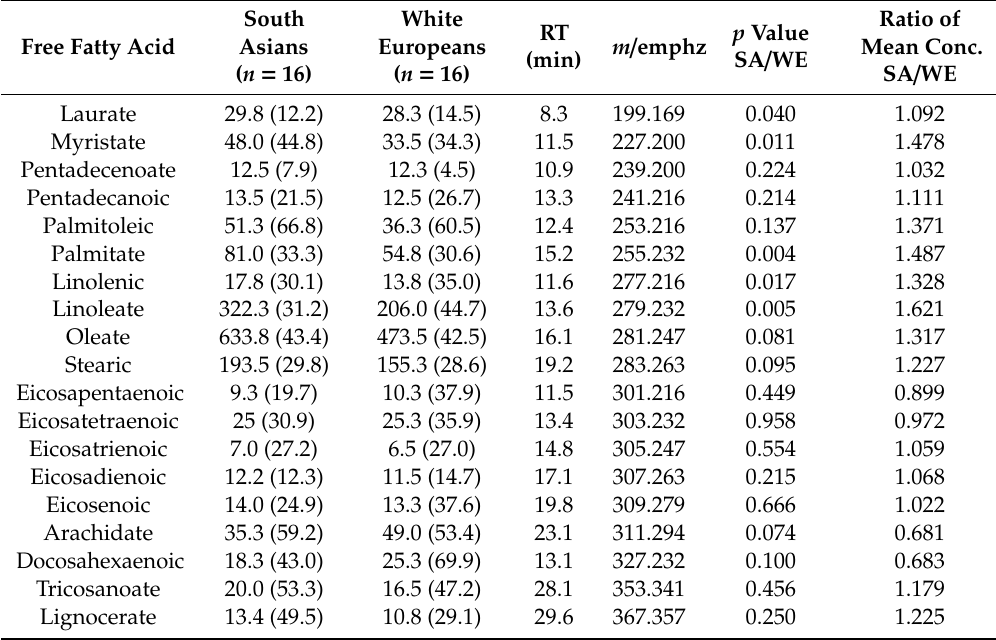
Table 2. Concentration of 19 FFAs in plasma from South Asian and white European men. Free Fatty Acid